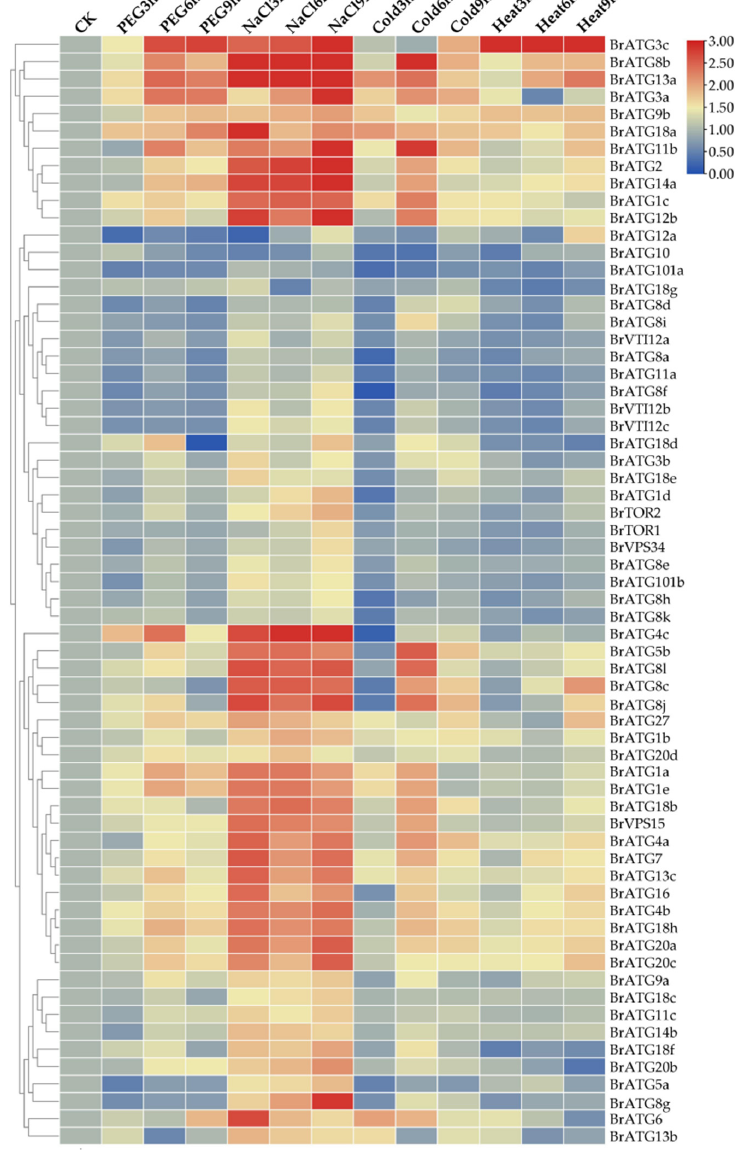
Figure 8. Analysis of gene expression patterns of BrATG genes under abiotic stresses (drought, NaCl, cold, and heat). Expression of 64 BrATG genes was detected using qRT–PCR under four stresses .